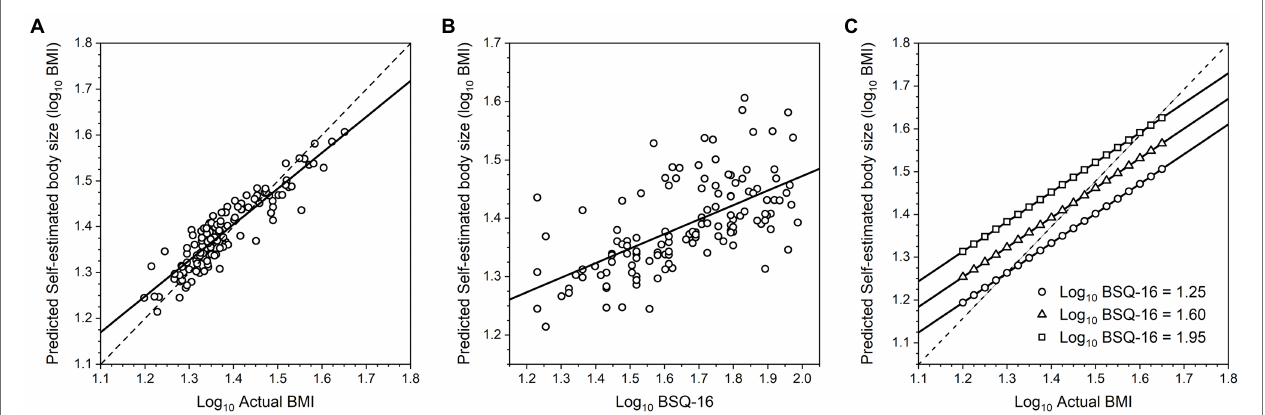
FIGURE 2 | (A) Scatter plot of log 10 self-estimated body size as a function of log 10 actual BMI, predicted from the multiple regression model. The dashed line represents the line of equivalence, that is, where participants’ estimates would exactly match their actual BMI, and this line has a slope of 1. The solid line represents the regression of log 10 self-estimated body size on log 10 actual BMI across the whole sample, and this has a slope less than 1. (B) Scatter plot of log 10 self-estimated body size as a function of log 10 BSQ-16, predicted from the multiple regression model. (C) Graphical illustration of the multiple regression of log 10 self-estimated body size on log 10 actual BMI, at three levels of log 10 BSQ-16, corresponding to BSQ-16 scores of ~18, ~40, and ~ 90. This graph therefore illustrates: (A) there is evidence for contraction bias across the entire sample, and (B) at any actual BMI, increasing BSQ-16 increases self-estimates of body size